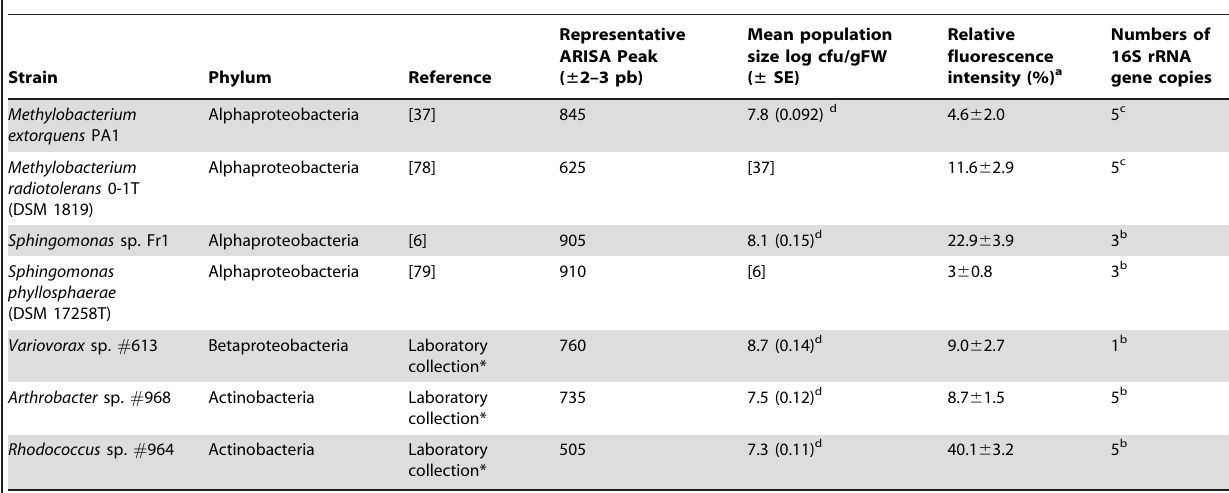
Table 1. Bacterial strains to build the synthetic community used in this